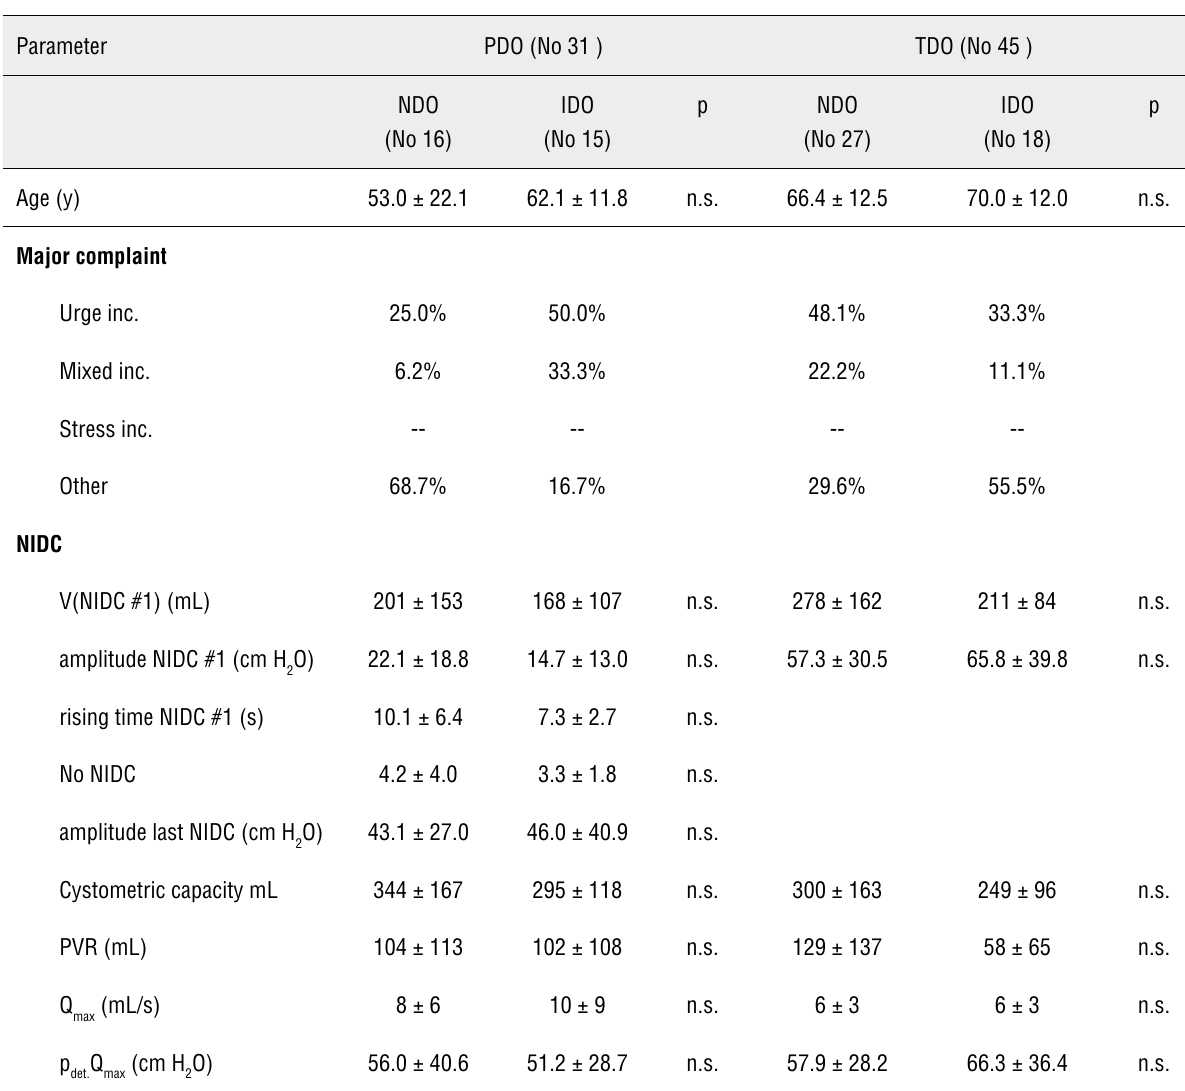
Table 4 - Demographic and urodynamic characteristics of the male population (PDO: phasic detrusor overactivity, TDO: terminal detrusor overactivity, NDO: neurogenic detrusor overactivity, IDO: idiopathic detrusor overactivity, NIDC non-inhibited detrusor contraction, PvR post void residual volume, Qmax maximum flow rate, pdet.Qmax detrusor pressure at maximum flow